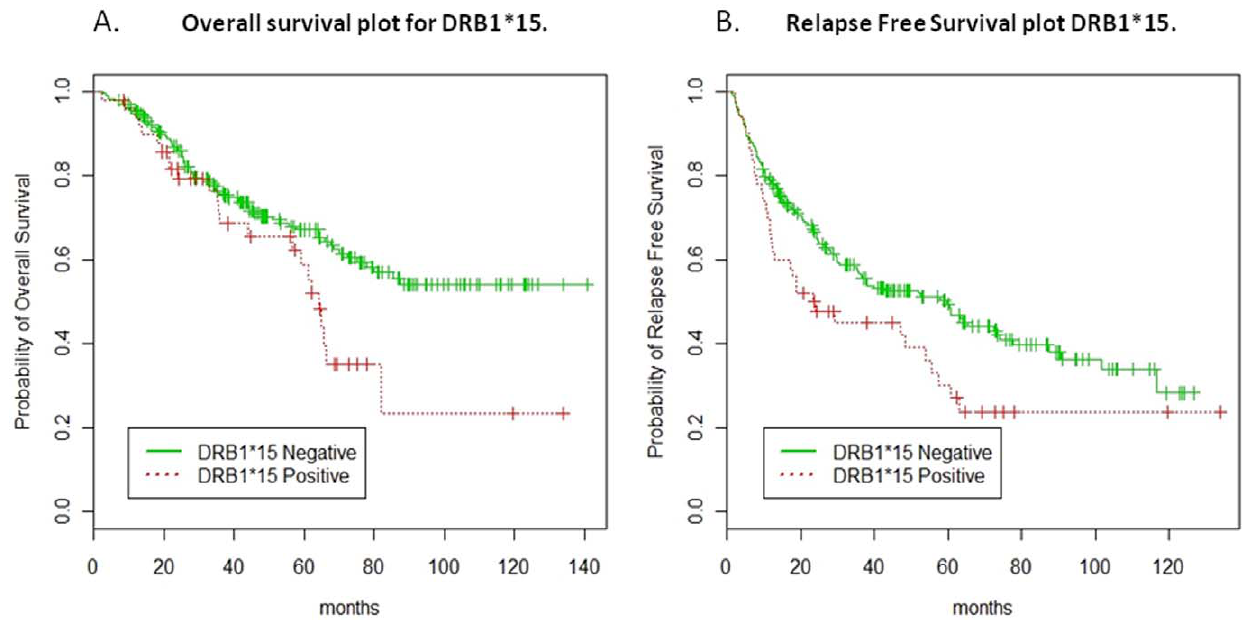
Figure 1. Kaplan-Meier curves for DRB1*15 for OS and RFS. The Leave-One-Out Cross Validated (LOOCV) Kaplan-Meier curves to compare DRB1*15 positive (red line) and negative patients (green line) for OS (log rank p value=0.027) (Figure 1A) and RFS (log rank p value=0.025) (Figure 1B), respectively.